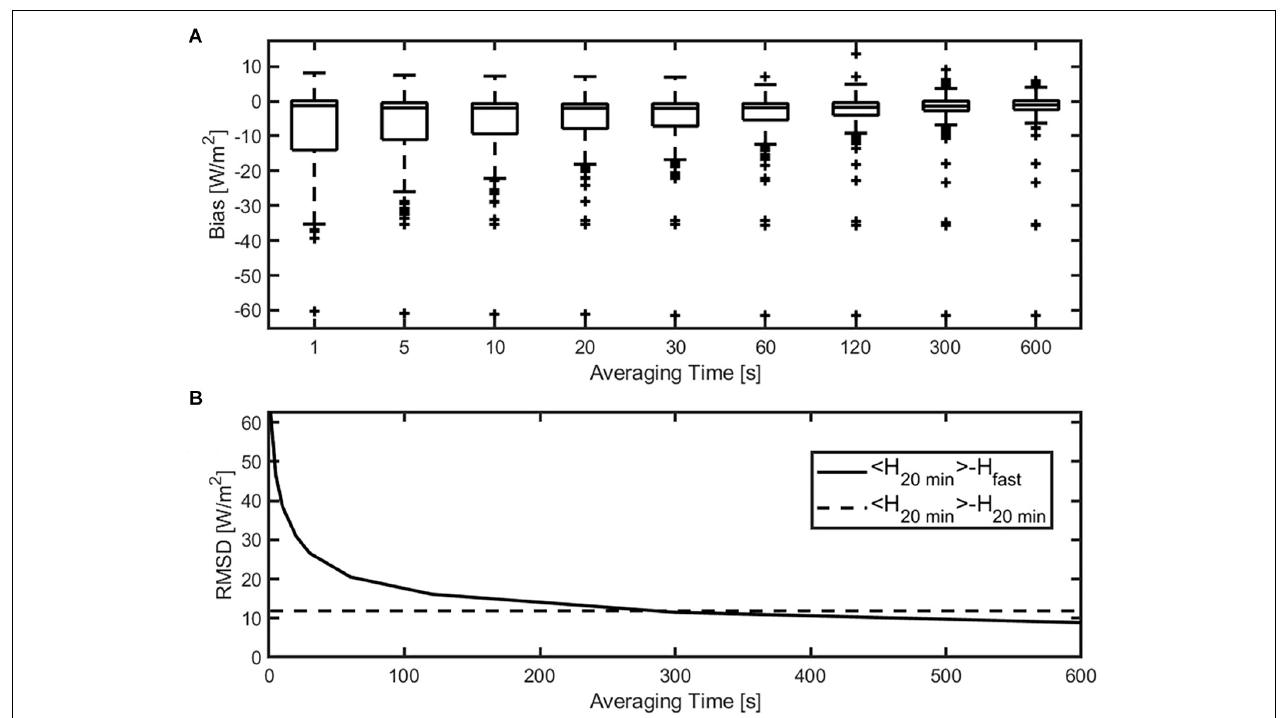
FIGURE 8 | Quantitative comparisons of STE averaging times for (A) bias and (B) root-mean-square difference (RMSD).